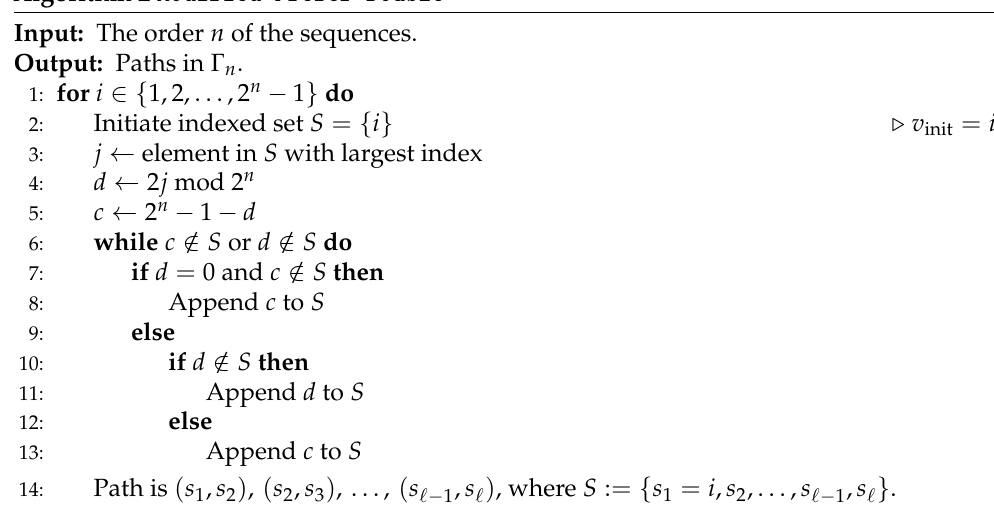
Algorithm 2 Modified Prefer Double